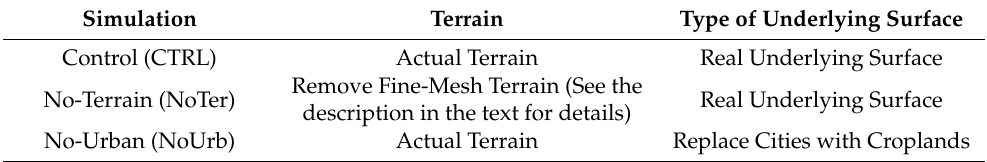
Table 1. Control and sensitivity